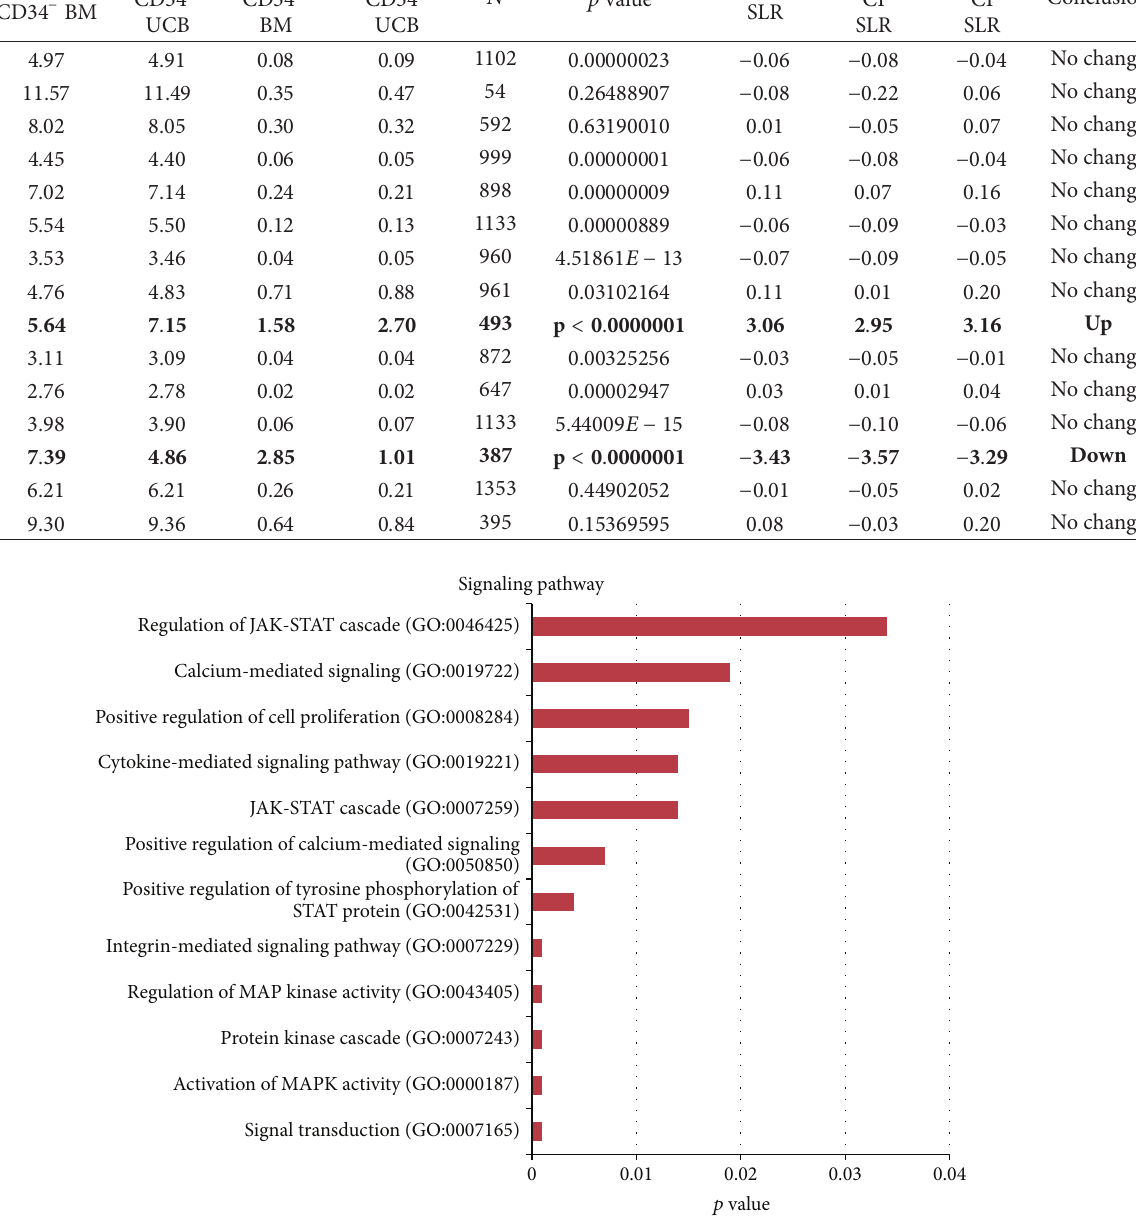
Figure 2: Functional annotations. 12 GO classification terms for biological processes in the group; signaling pathways in cluster 9 depending on the 𝑝 value ( 𝑝 < 0.04